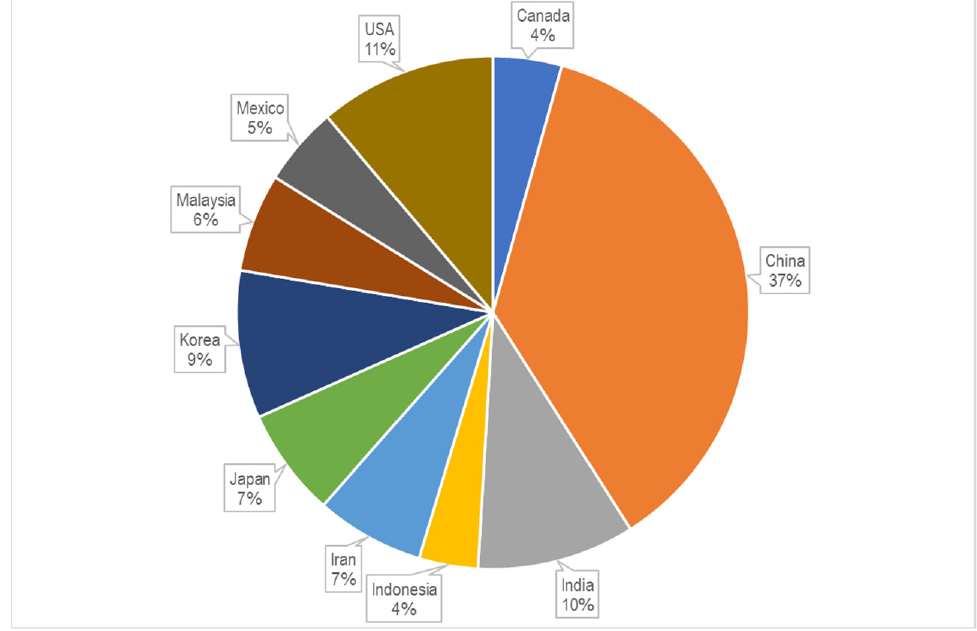
Figure 2. Shares of publications per country or region (source: www.lens.org; accessed on 21 December 2022).